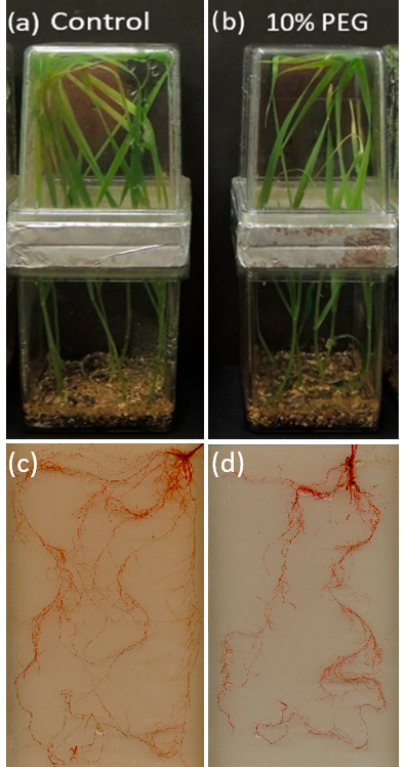
Figure 1. Wheat plants grew in magenta boxes. ( a ) control treatment, ( b ) 10% PEG 6000 (osmotic stress), ( c , d ) selected stained root for photo scanning and analyzing of control and PEG treatment,